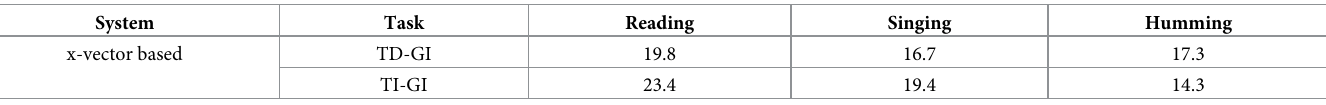
Table 10. EER% on the x-vector based ASV tasks using the whole RSH to train the x-vector extractor, and multi-speaking style training data combination for the tar- get speaker enrollment. System Task Reading Singing Humming x-vector